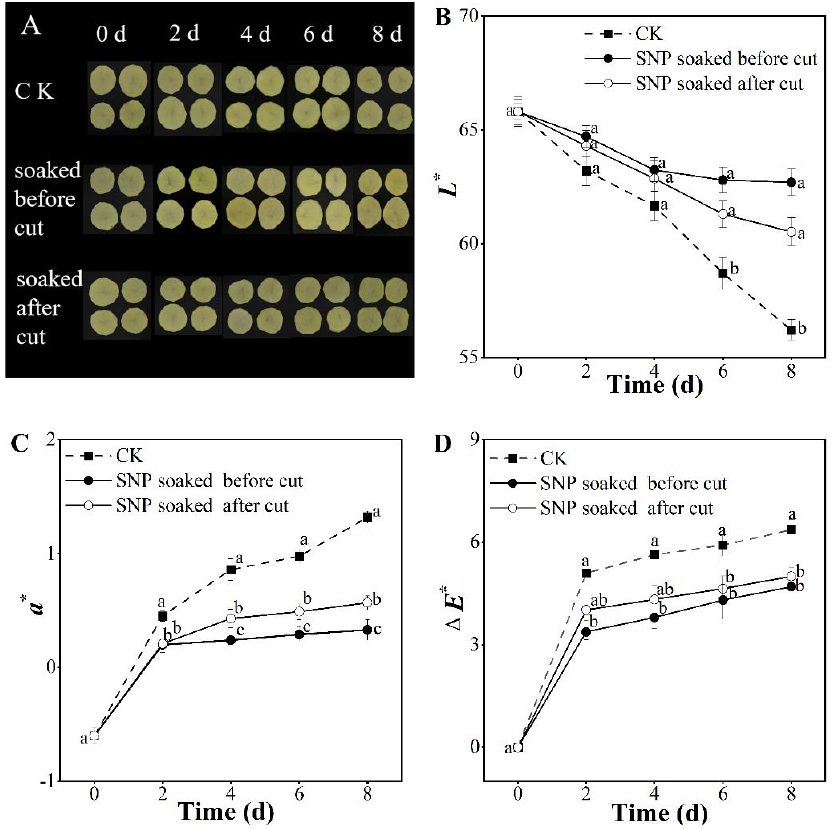
Figure 1. Effect of SNP treatment on visual appearance ( A ) and color of L * ( B ), a * ( C ), and Δ E * ( D ) of fresh-cut potatoes. Different letters indicate significant differences among treatments at same storage time ( p < 0.05).